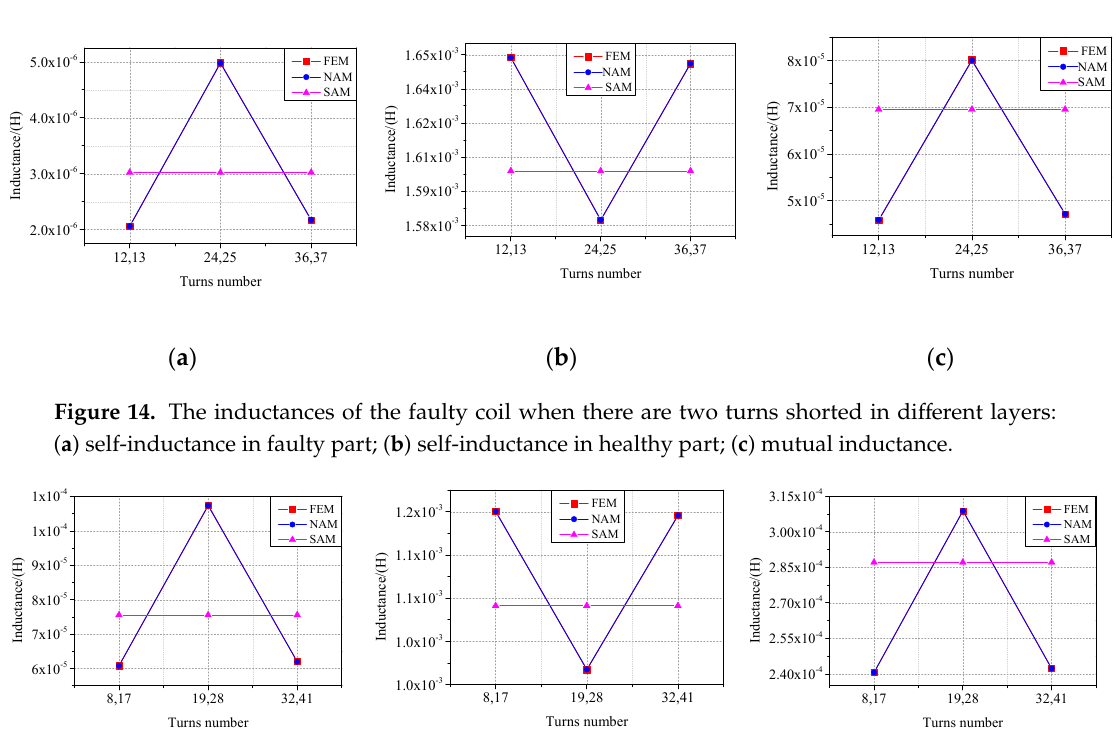
Figure 15. The inductances of the faulty coil when there are 10 turns shorted in different layers: ( a )